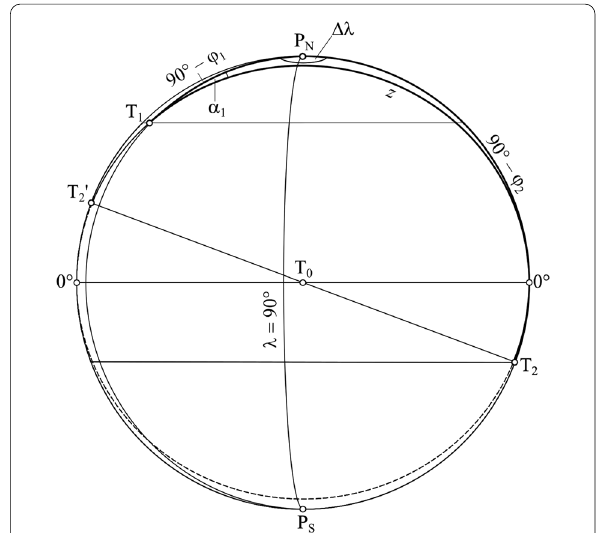
Fig. 2 Earth’s hemisphere shown in equatorial orthographic projection with construction pole T 0 (φ 0